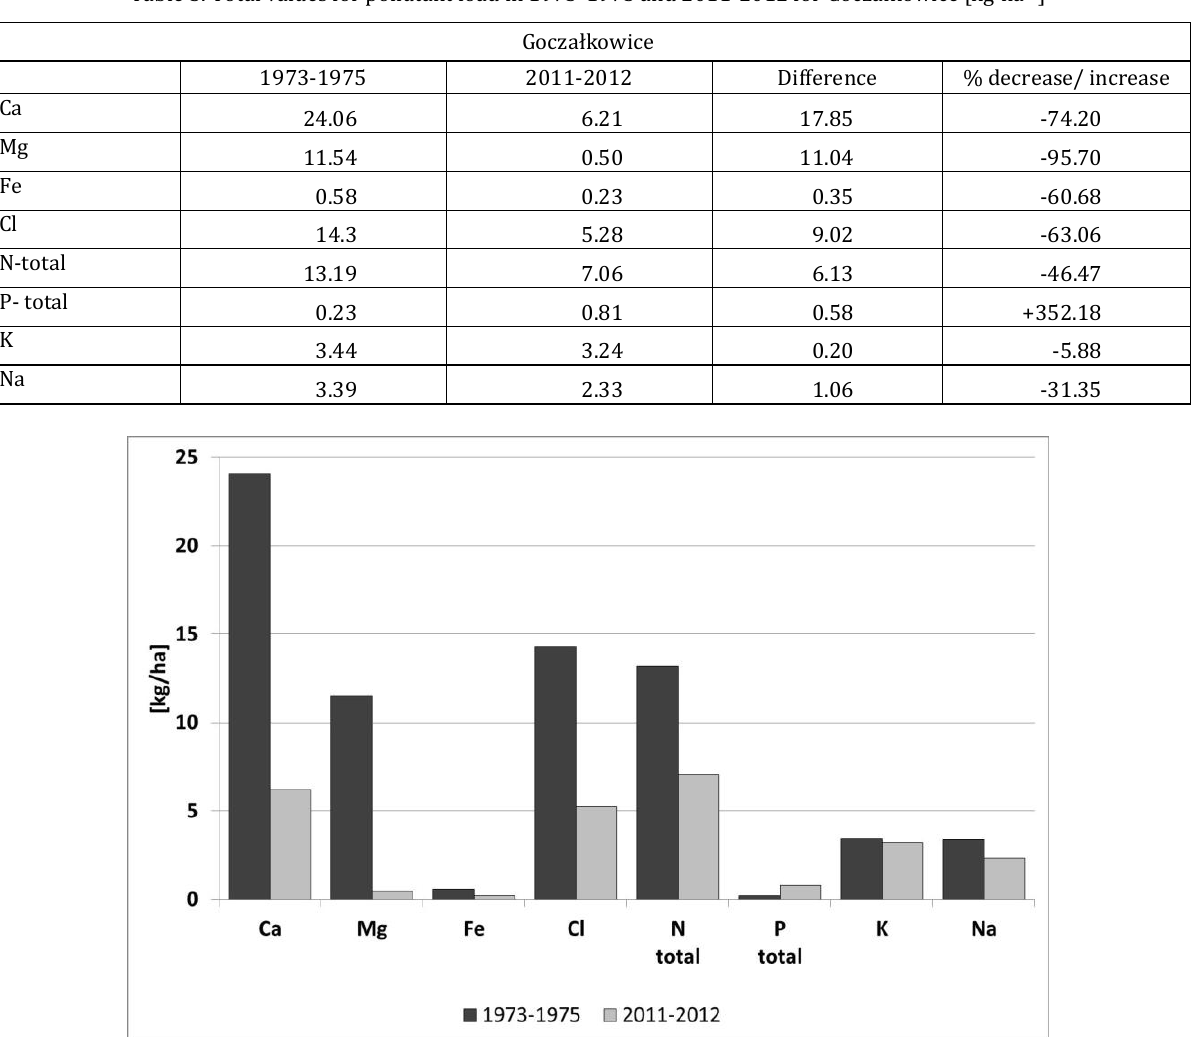
Fig. 9. Mean wet deposition values for Goczałkowice for the periods 1973-1975 and 2011-2012 [kg·ha -1